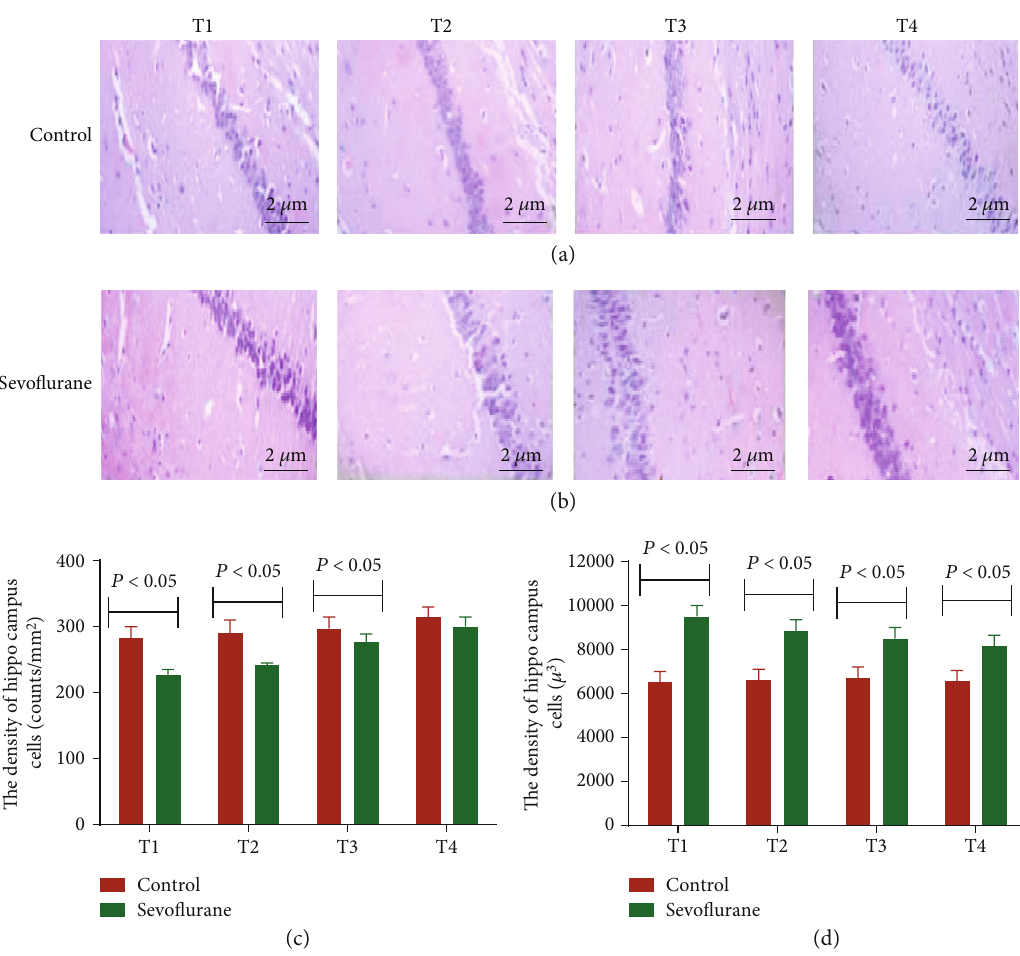
Figure 2: H&E stain analysis of the nerve cells in the hippocampus between the control and sevo fl urane groups. According to the di ff erent time points of the behavioral experiment test, the mice were stopped for the inhalation of sevo fl urane or oxygen after 12 h (T1), 24 h (T2), 48h (T3), and 72h